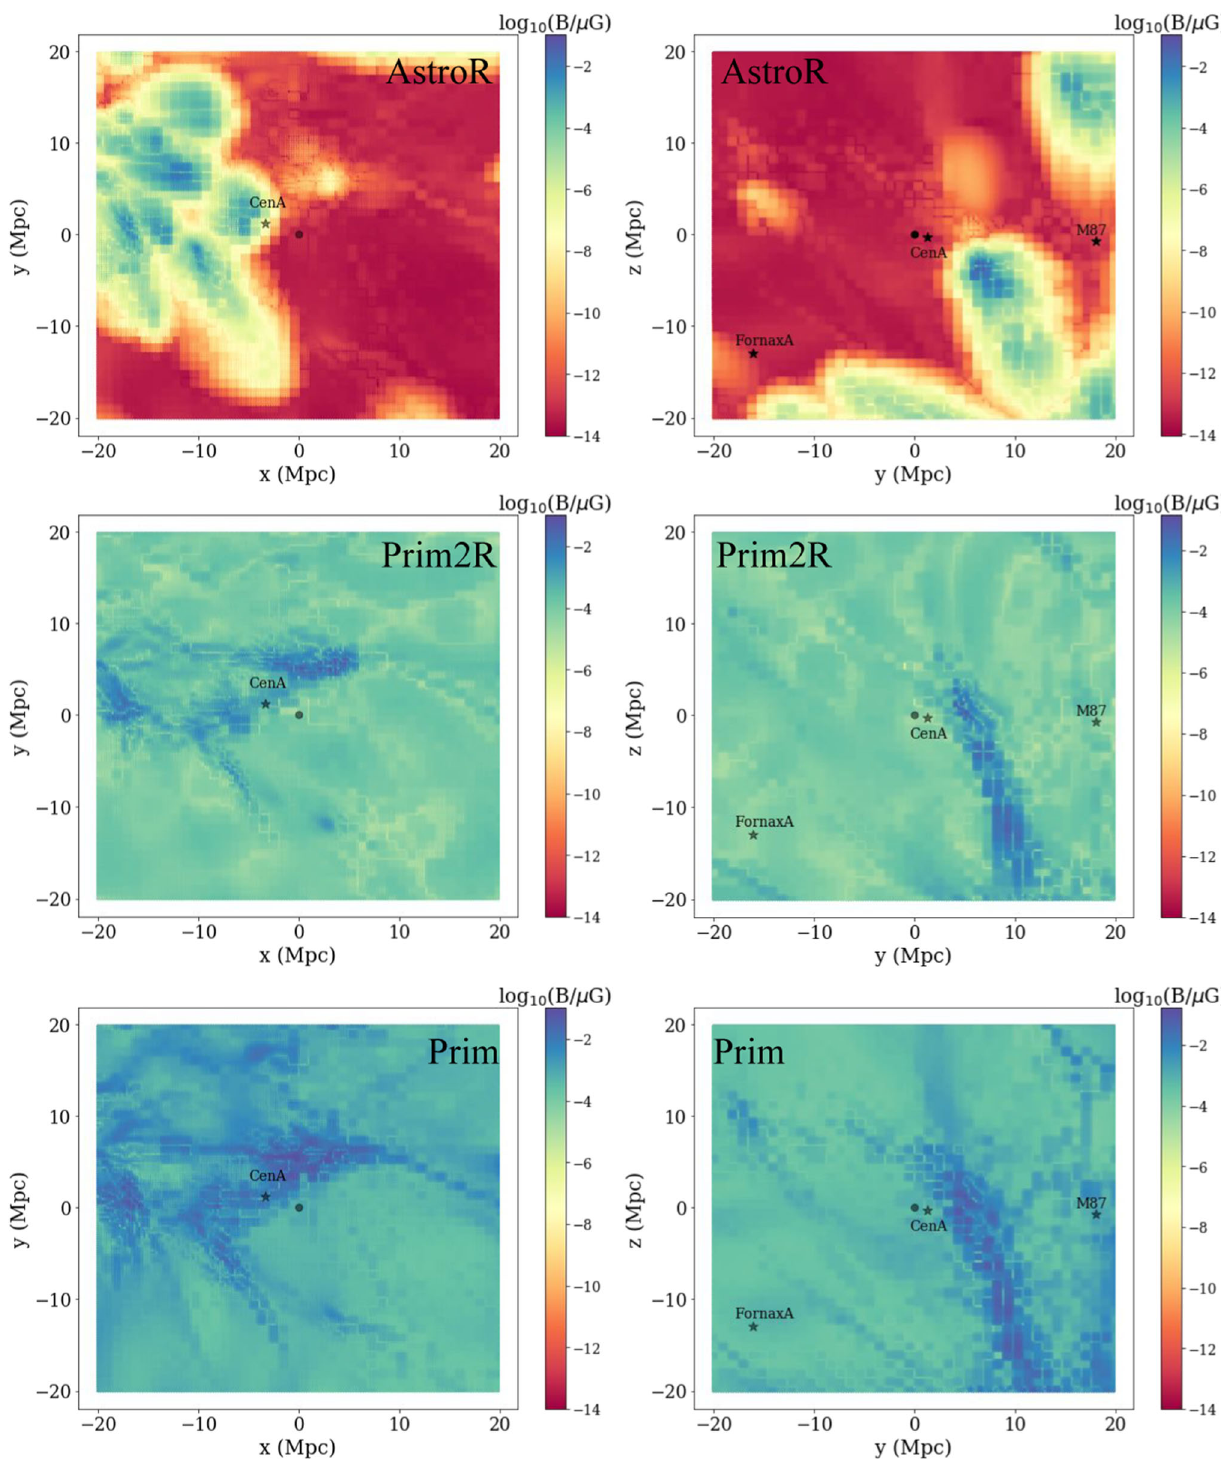
Fig. 2 Extragalactic magnetic field intensity (xy- and yz-plane) in an 20 Mpc sphere around Earth for the three models used in this paper: AstroR, Prim2R and Prim according to reference [35]. Stars show the position of Cen A, Fornax A and M87. The center of the map showed by a circles is the the Milky